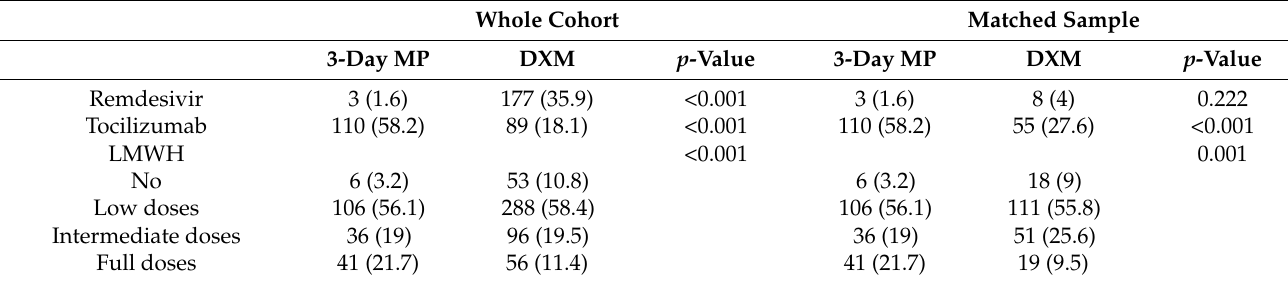
Table 4. Comparison of additional treatments between